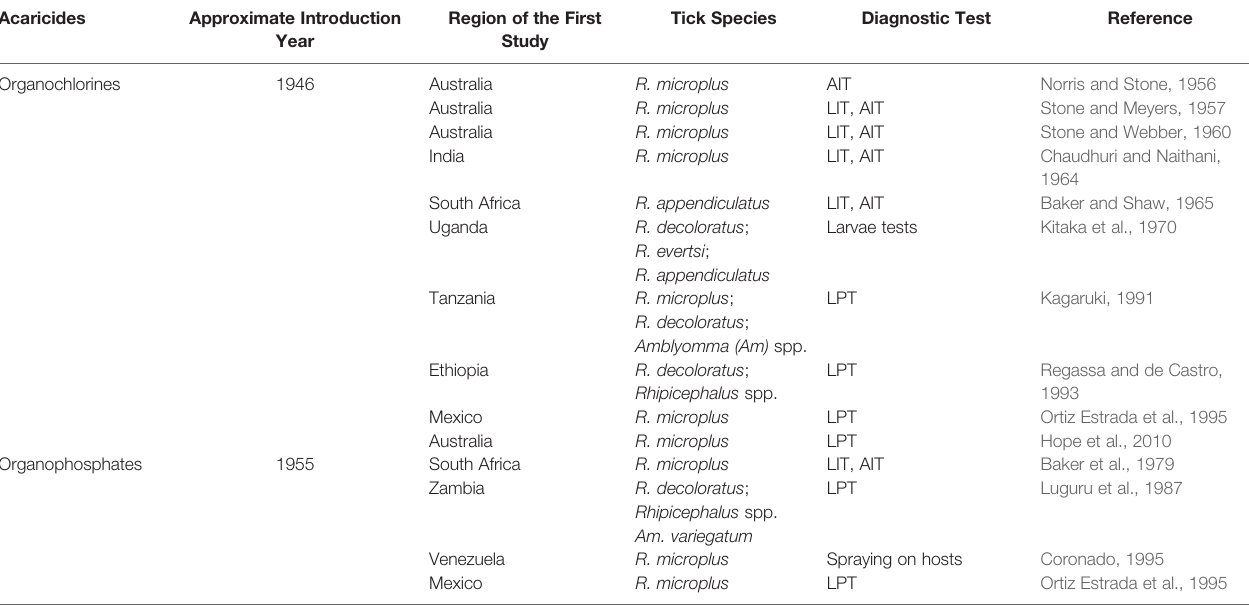
TABLE 1 | Historical and regional aspects of different acaricides, resistant ticks and diagnostic